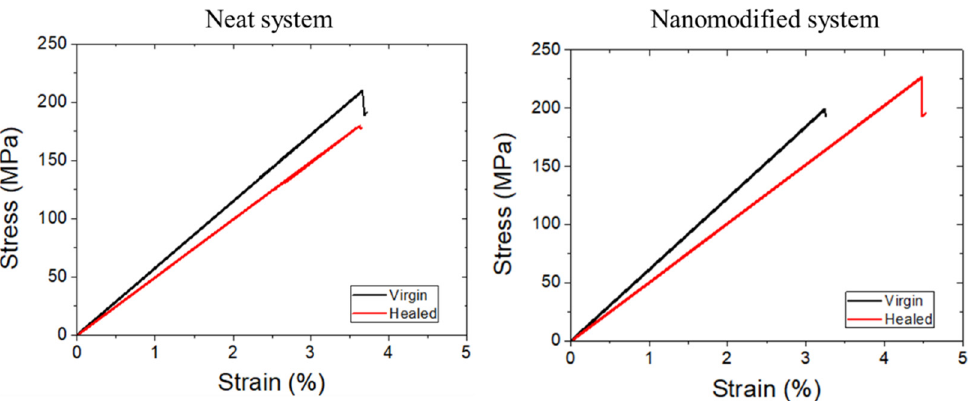
Figure 11. Representative plots of the virgin (black line) and healed (red line) lap strap specimens containing neat and nanomodified capsules. Table 3. Healing efficiency and change in initial mechanical properties of lap strap specimens containing neat and nanomodified